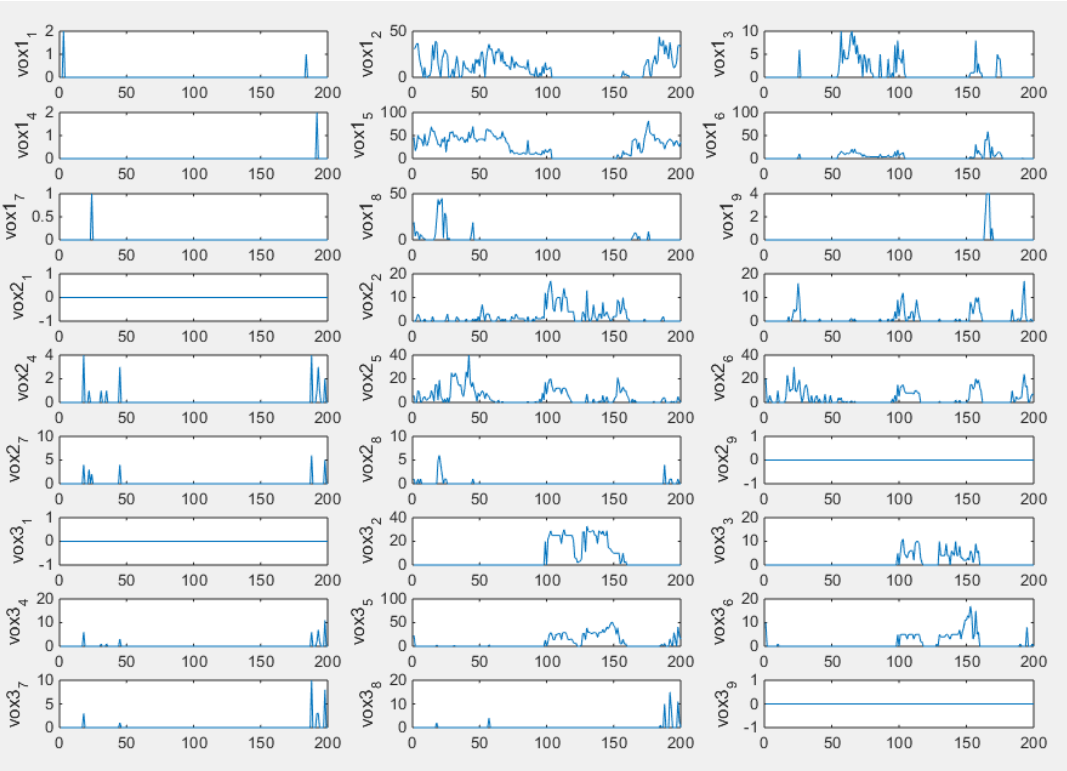
Figure 14. Reconstructions of the movement using temporal TV: a dynamic 3D image was produced, and 16 images selected among 200 frames showing that the movement of inclusion was started from the top move down to the bottom, and come back to top. The Blue object in images (refer to the color bar) corresponds to where the inclusion arrived at that time-step.